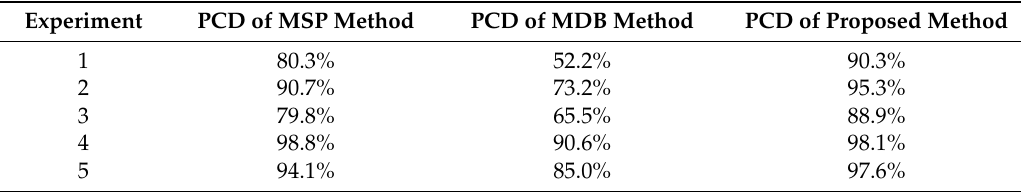
Table 3. Experimental